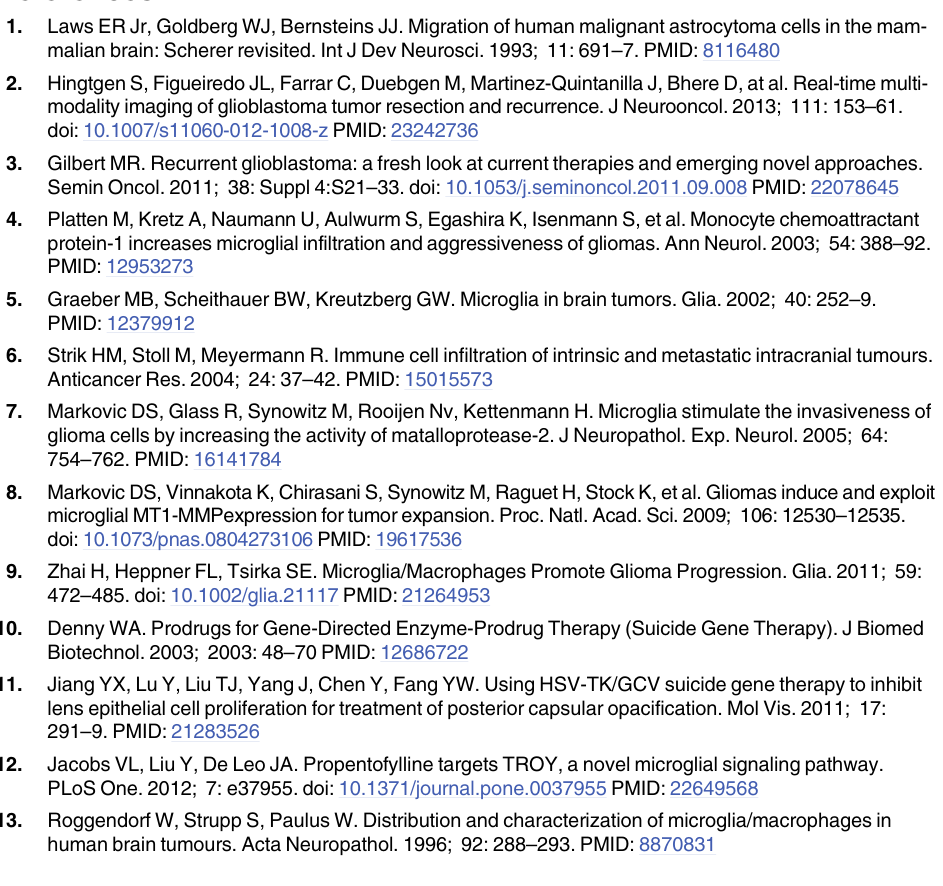
S5 Fig. Western Blot (A) and quantification of Pyk2 protein levels (B) for control (MOCK transfected) U87 glioma cells and cells transfected with 10 nM siRNA against Pyk2. Mono- clonal mouse anti-Pyk2 antibody were used (Cell Signaling; #3480S), dilution 1:1000, followed by anti-mouse conjugated immunoglobulins (Cell